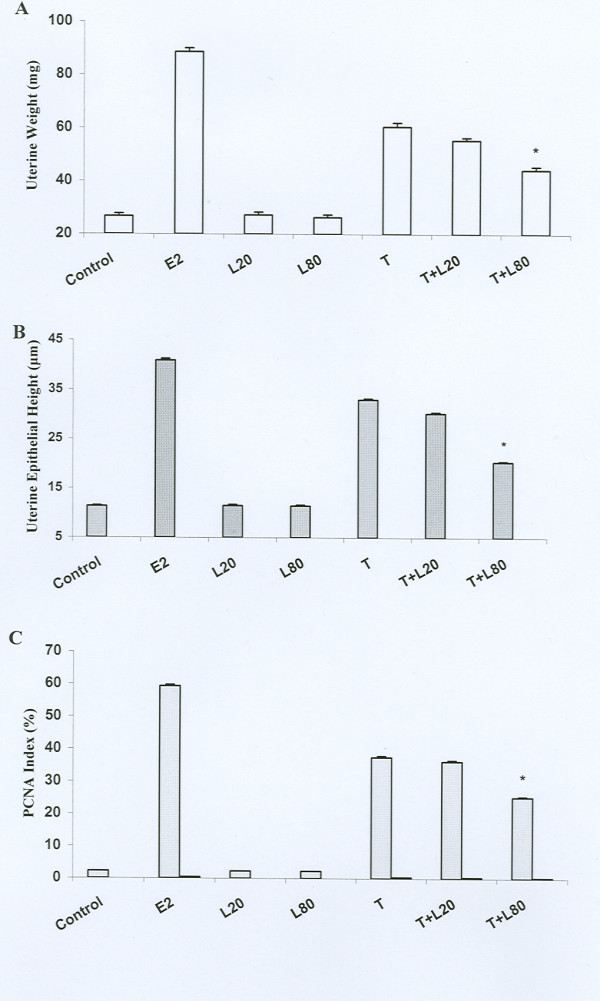
Effects of liarozole fumarate (R85246) in combination with tamoxifen on N-methyl-N-nitrosourea (MNU)-induced mammary carcinoma and uterus in the rat model. Effects of liarozole alone and in combination with tamoxifen on uterine wet weight (a), uterine epithelial lining cell height (b) and PCNA index (c). Scale bars represent group mean ± SEM. Treatment groups: OVX controls, 17β-estradiol 10 μg/kg (E2), liarozole 20 mg/kg (L20), liarozole 80 mg/kg (L80), tamoxifen 1 mg/kg (T), tamoxifen 1 mg/kg + liarozole 20 mg/kg (T+L20), tamoxifen 1 mg/kg + liarozole 80 mg/kg (T+L80). *P < 0.05 versus tamoxifen 1 mg/kg (T).